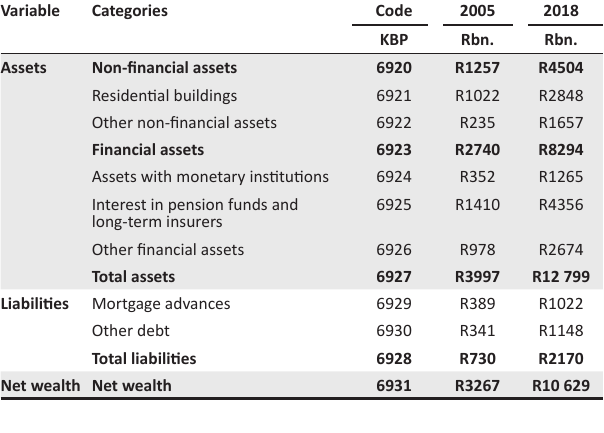
TABLE 2: Balance sheet of the household sector, 2005 and 2018.